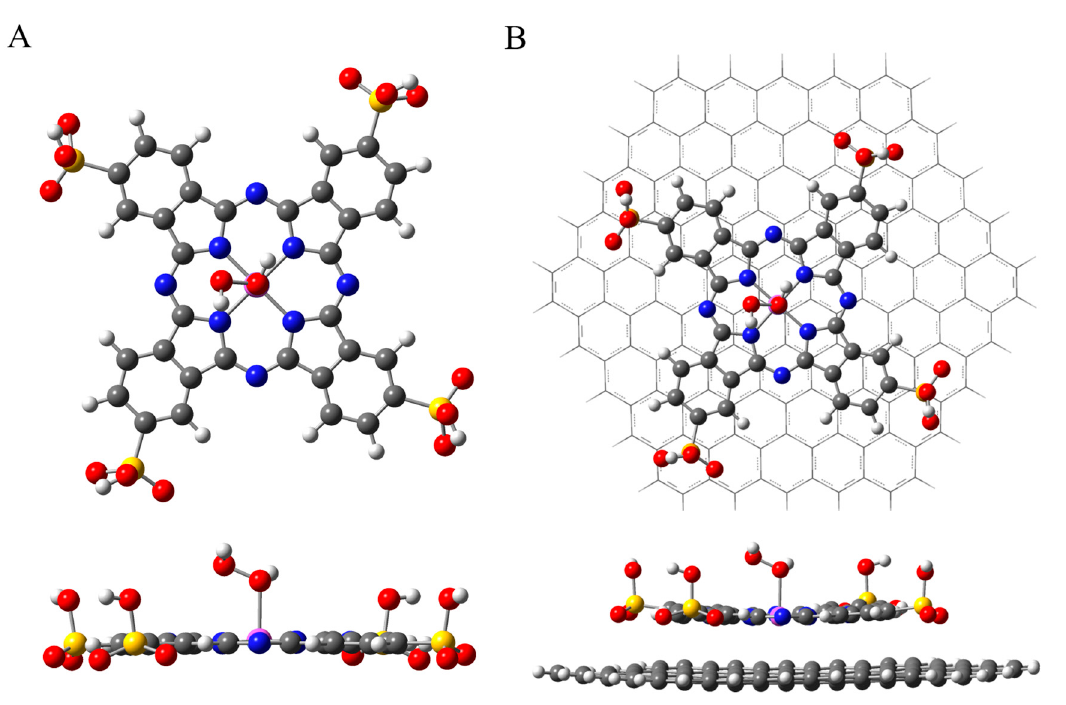
Figure 8. Fully optimized geometries of PcS–H 2 O 2 in the absence ( A ) and presence ( B ) of graphene. The purple, blue, yellow, red, black, and white balls represent Co, N, S, O, C, and H atoms, respectively.